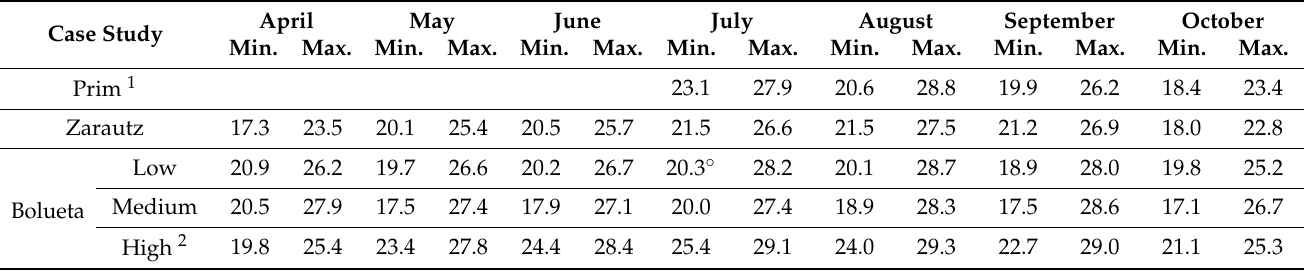
As for the maximum and minimum temperatures recorded during the monitoring period, it is notable that, frequently, the Bolueta Low, Medium and High study cases seemed to have a larger amplitude with higher peaks and lower valleys, as shown in Table 10 and also in Figure 17. Table 10. Minimum and maximum recorded temperatures (°C) for each of the case studies, April–